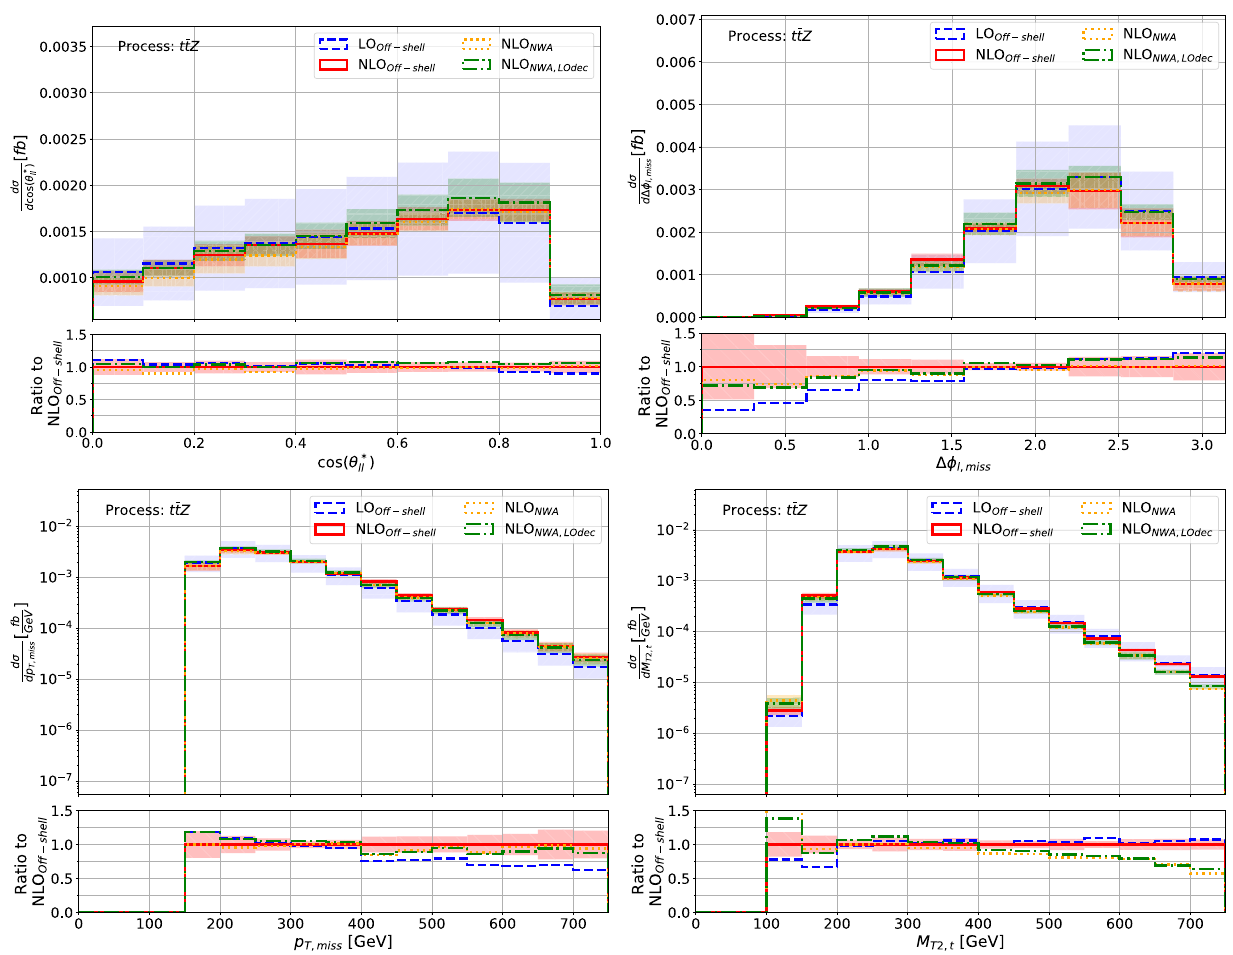
√ s = 13 TeV. The error bands depict LHC with center of mass energy the respective scale uncertainties. In the lower panels we present the ratios to the NLO Off-shell